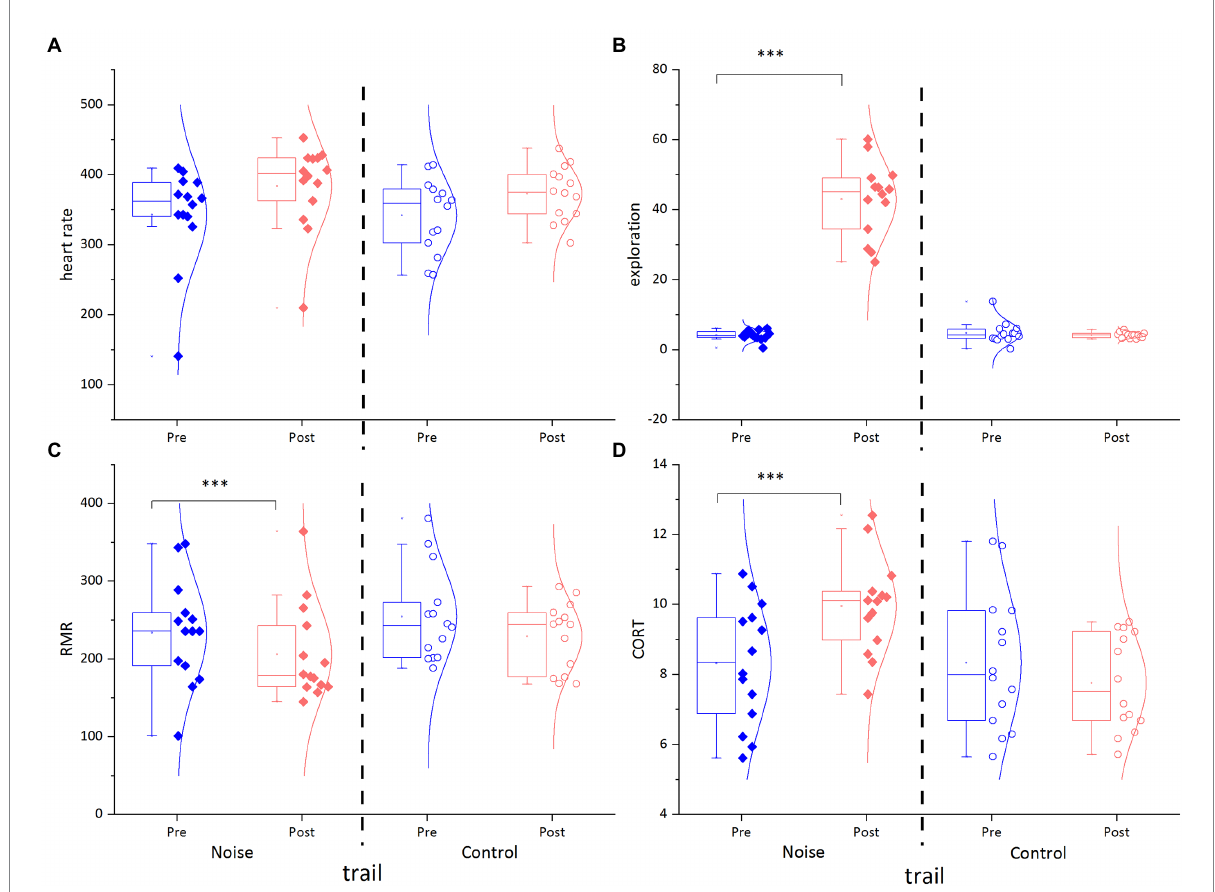
FIGURE 2 Effect of treatment on behavioral and physiological traits pre and post experiment in the Noise and Control groups. (A) Heart rate under handling, (B) exploration, (C) RMR, and (D) fecal